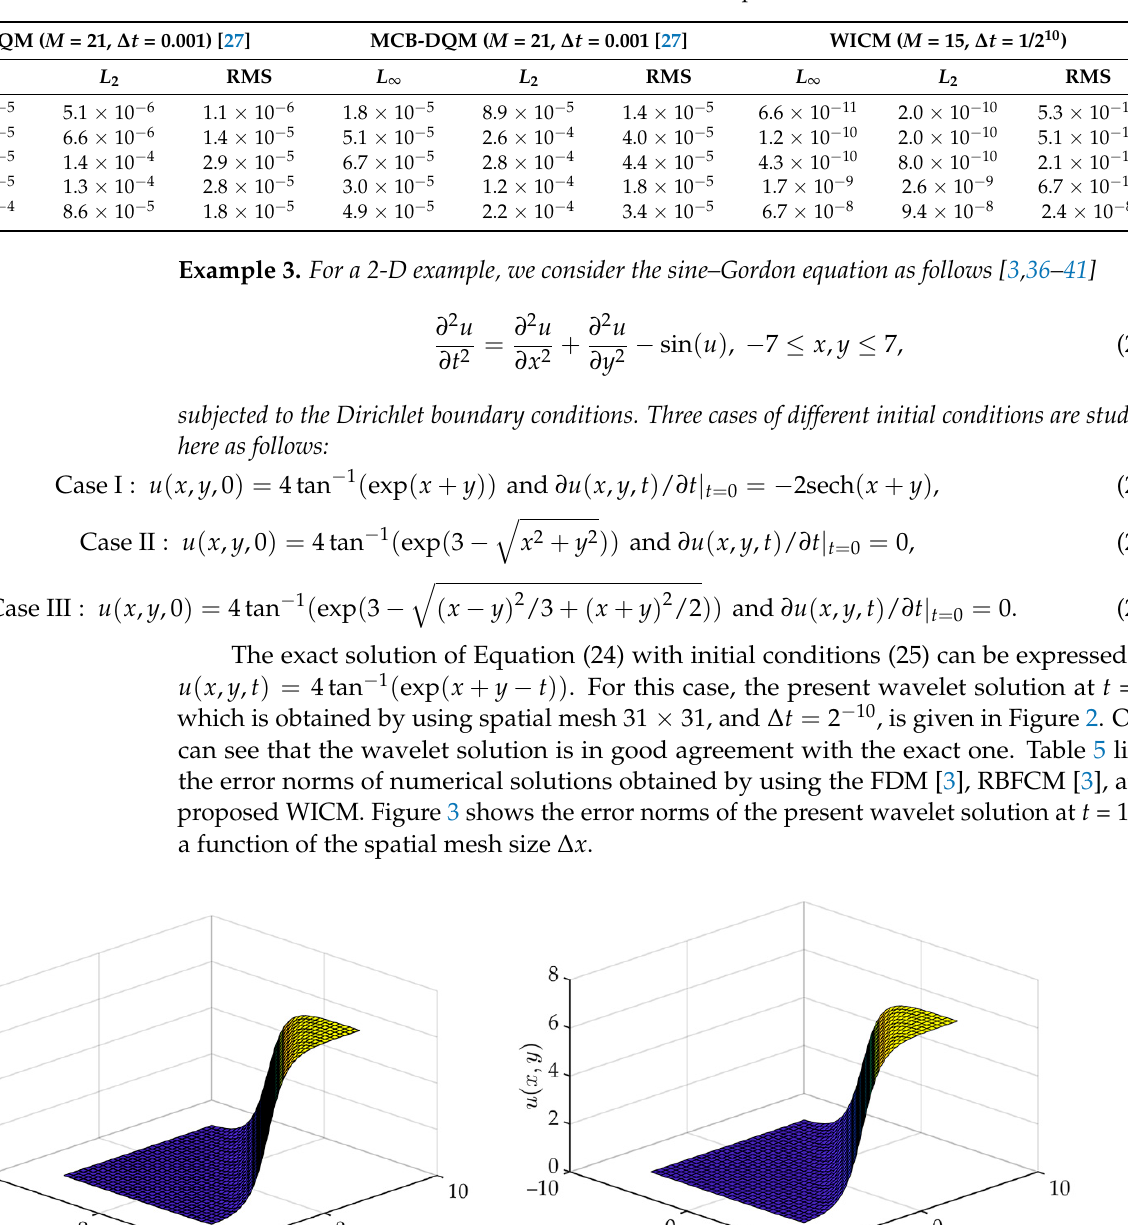
Figure 3. Relation between error norms of the wavelet solution at t = 1 and the spatial mesh size Δ x for Case I of Example 3. The numerical results of Case II are shown in Figures 4 and 5, where the spatial mesh N = 31 × 31 and time step Δ t = 1/2 10 are used. From Figures 4 and 5, we can see that a